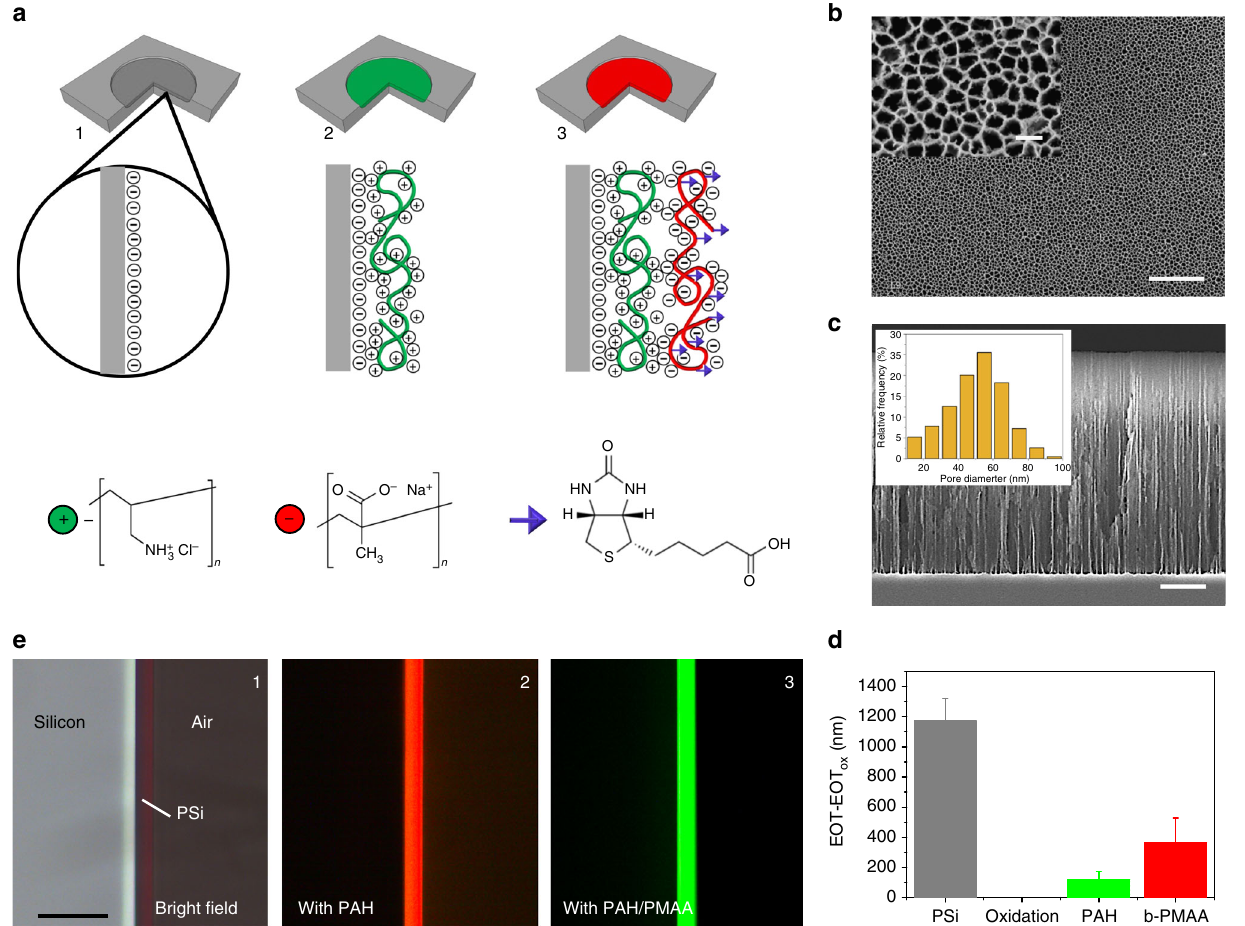
Fig. 2 Layer-by-Layer biofunctionalization of nanostructured PSi interferometers. a Sketch of the biofunctionalization of the nanostructured surface of PSi interferometers via LbL nano-assembly: (1) preparation and oxidation of PSi interferometers (gray, negatively charged); (2) PAH coating (green, positively charged) of oxidized PSi interferometers; (3) b-PMAA (biotinylated PMMA) coating (red, negatively charged) of PSi/PAH interferometers. Details of the chemical structure of the polyelectrolytes used for LbL assembly, namely PAH (green circle) and PMAA (red circle), and of biotin (violet triangle) covalently linked to PMAA by amino-coupling, are given at the bottom of a . b SEM top-view image (50,000 × magni fi cation) of the PSi interferometer surface (scale bar is 1.00 µ m). The inset shows a higher magni fi cation SEM image (200,000 × magni fi cation) of the PSi surface that allows pore arrangement and size to be clearly appreciated (scale bar is 100 nm). c SEM cross-section image (25000 × magni fi cation) of the PSi interferometer highlighting the columnar structure of the pores (scale bar is 1.00 μ m). The inset shows a histogram of the pore size distribution, highlighting an average diameter of about 55 nm. d EOT-EOT ox values recorded for PSi interferometers both as-prepared and after each LbL biofunctionalization step. The EOT value of oxidized PSi interferometers (i.e., EOT ox ) is used as reference to obtain positive differential EOT values. Data are provided as average values over seven replicates with error bars representing one standard deviation. e Bright- fi eld optical image (1) and fl uorescence images (2, 3) of the cross-section of oxidized PSi interferometers LbL-coated with (2) sulfo-rhodamine-labeled PAH and with (3) fl uorescein-labeled PMAA on top of non-labeled PAH coating (scale bar is 15 µ m). The homogeneity of the electrostatically driven LbL coating can be easily appreciated by the uniform fl uorescence emission of the labeled polyelectrolytes over the whole PSi fl uorescence images of oxidized PSi interferometers both bare (Supplementary Figure 2a, b) and coated with PAH/PMAA (Supplementary Figure 2c, d) are reported as Supplementary Information. From fl uorescence images, it is apparent that the pores are uniformly covered with both the polyelectrolytes all over their depth, in spite of their nanometric diameter (50 nm in average) and high aspect ratio (about 100).